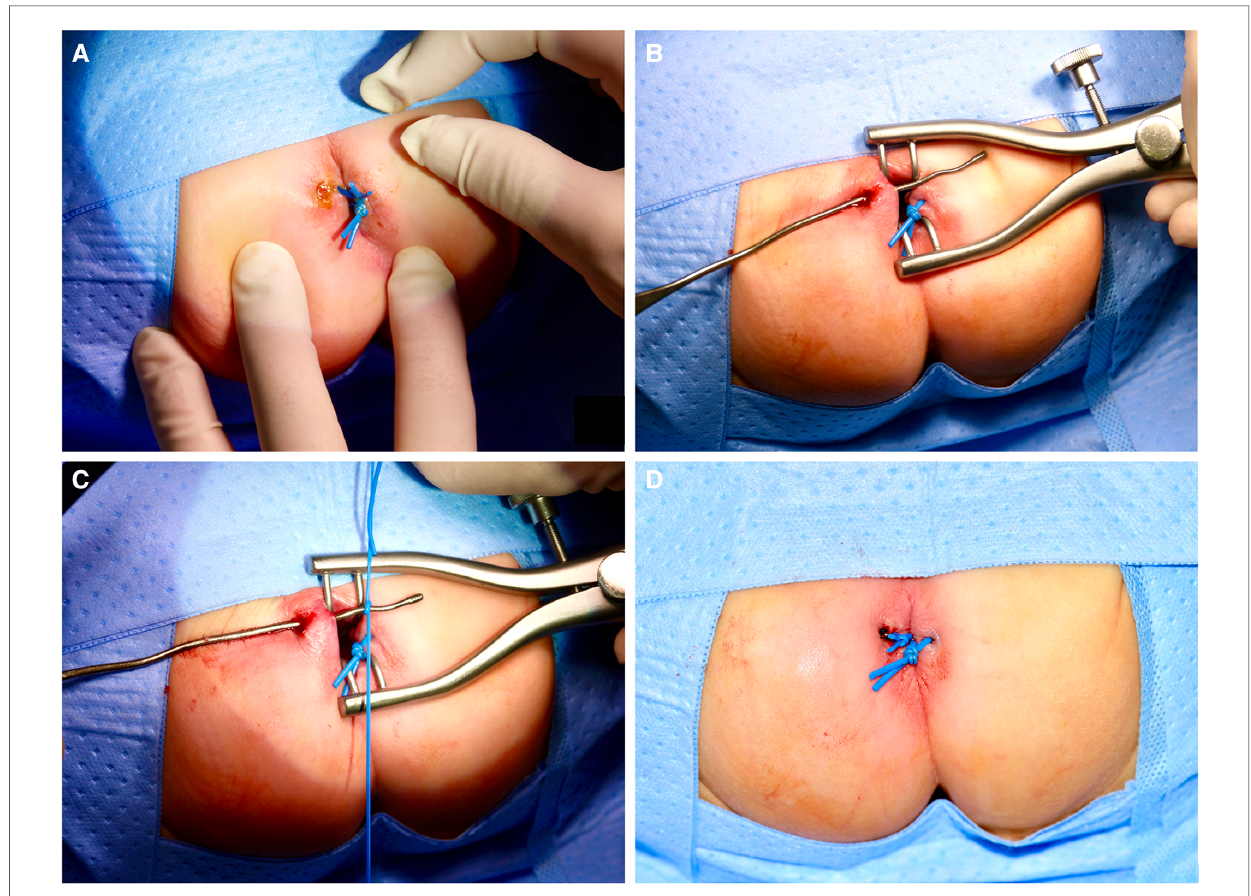
FIGURE 1 The surgical technique is illustrated by an exemplary case of an infant of 10 months of age with two FIA. After placement of seton in a FIA at 3 o ’ clock, FIA with concomitant perianal abscess at 10 o ’ clock is explored ( A ). FIA is identi fi ed by the insertion of a bulb-headed lacrimal probe ( B ). The silicone vessel loop is attached ( C ) and pulled trough. The loop is ligated loosely outside the anus without any additional tension to the skin ( D